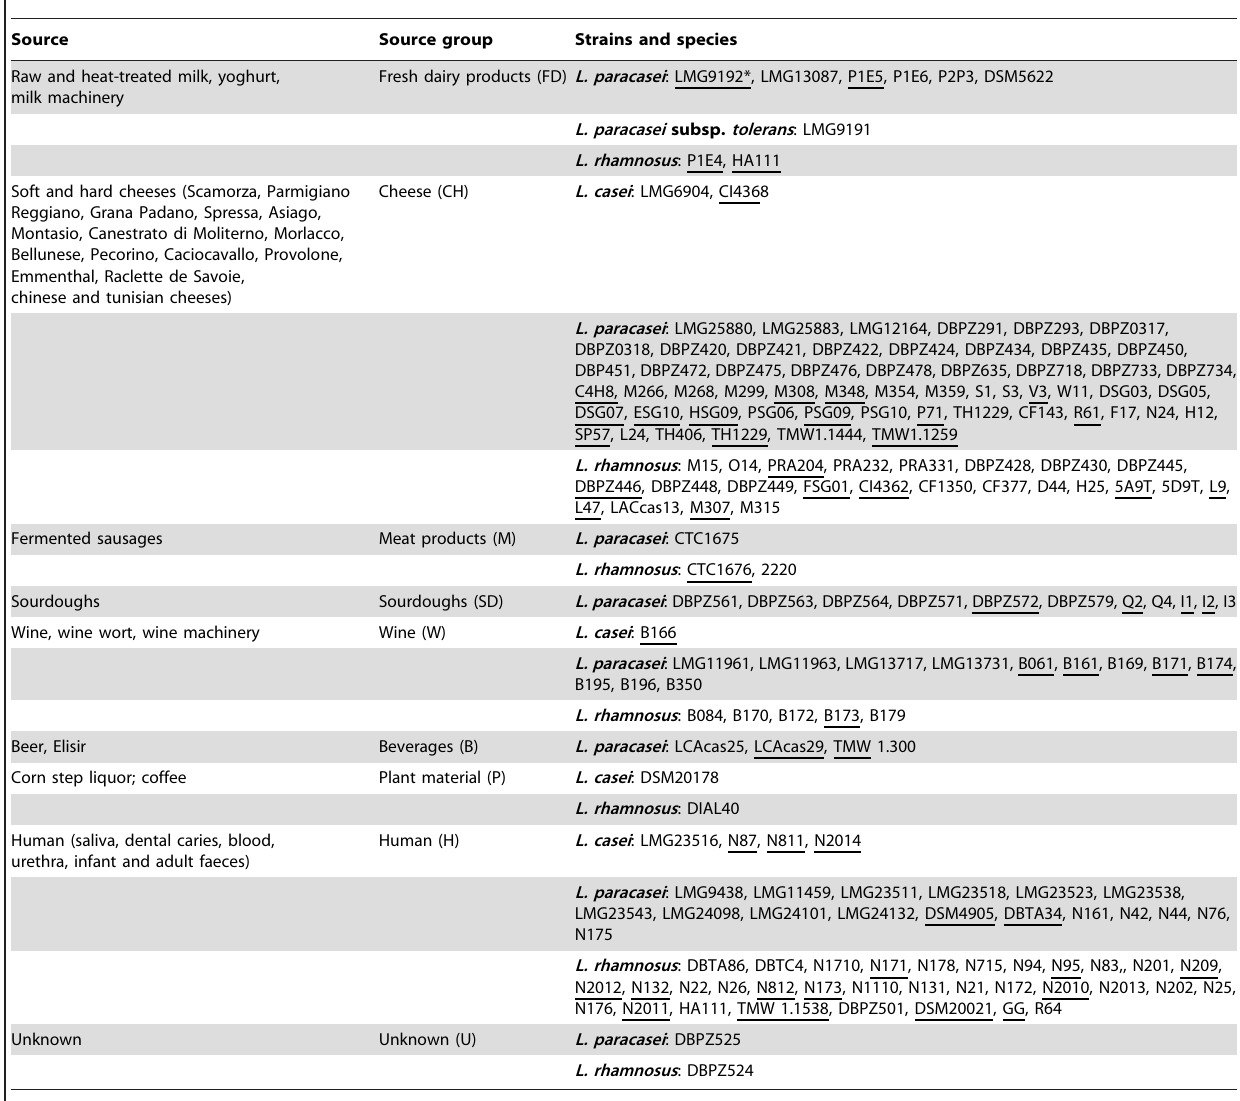
Table 1. List of strains used in this study.